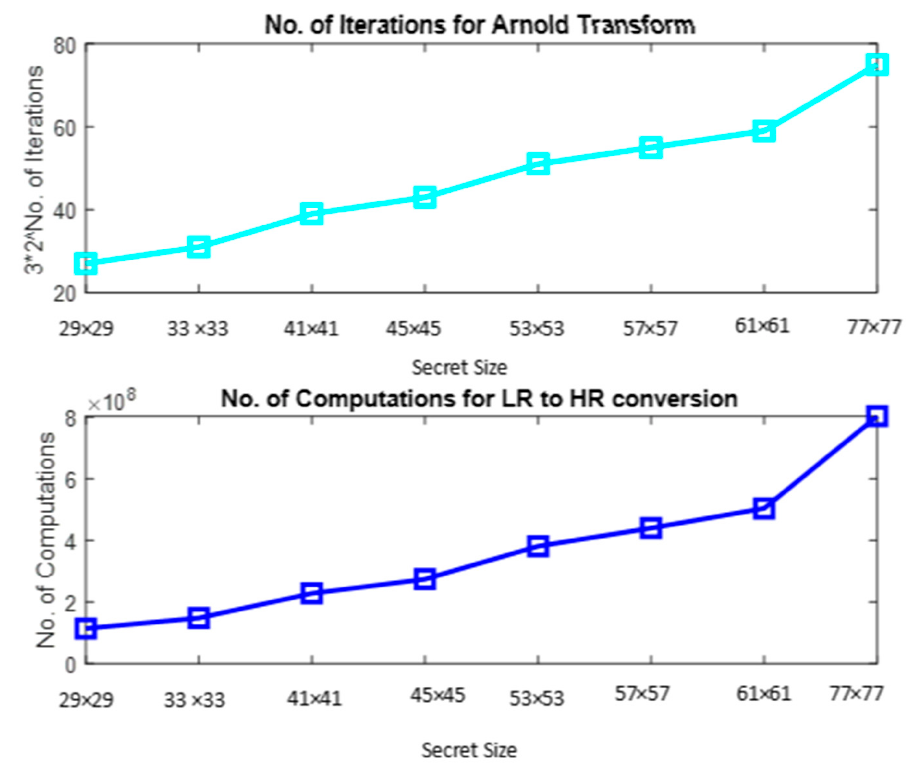
Figure 10. Brute-force attack—number of iterations for Arnold Transform and number of computa- tions of Image Super Resolution.